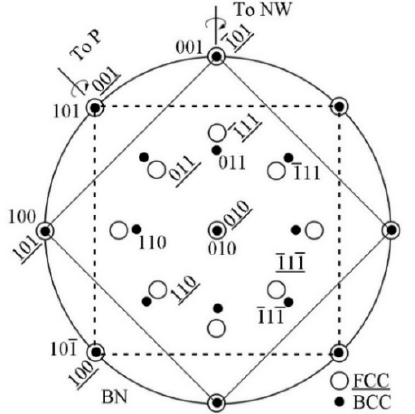
Figure 5. Schematic diagram showing the BN OR transformed to NW and P ORs.